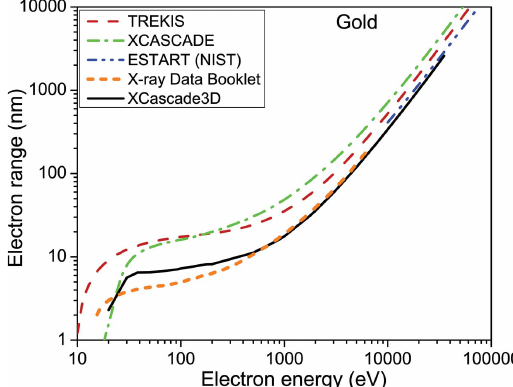
Figure 3 Electron range in gold according to XCascade3D simulations – solid black line; XCASCADE estimation within the continuous-slowing-down approximation – green dash-dotted line; energy loss function integral from the NIST database – blue dash-dot-dotted line (Berger et al. , 1998); TREKIS simulation tool – red dashed line (Medvedev et al. , 2015); X-ray Data Booklet – orange short-dashed line (Thompson et al. , 2009).